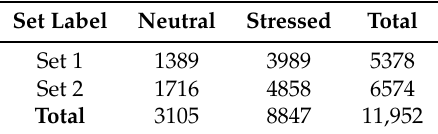
Table 1. Number of samples.